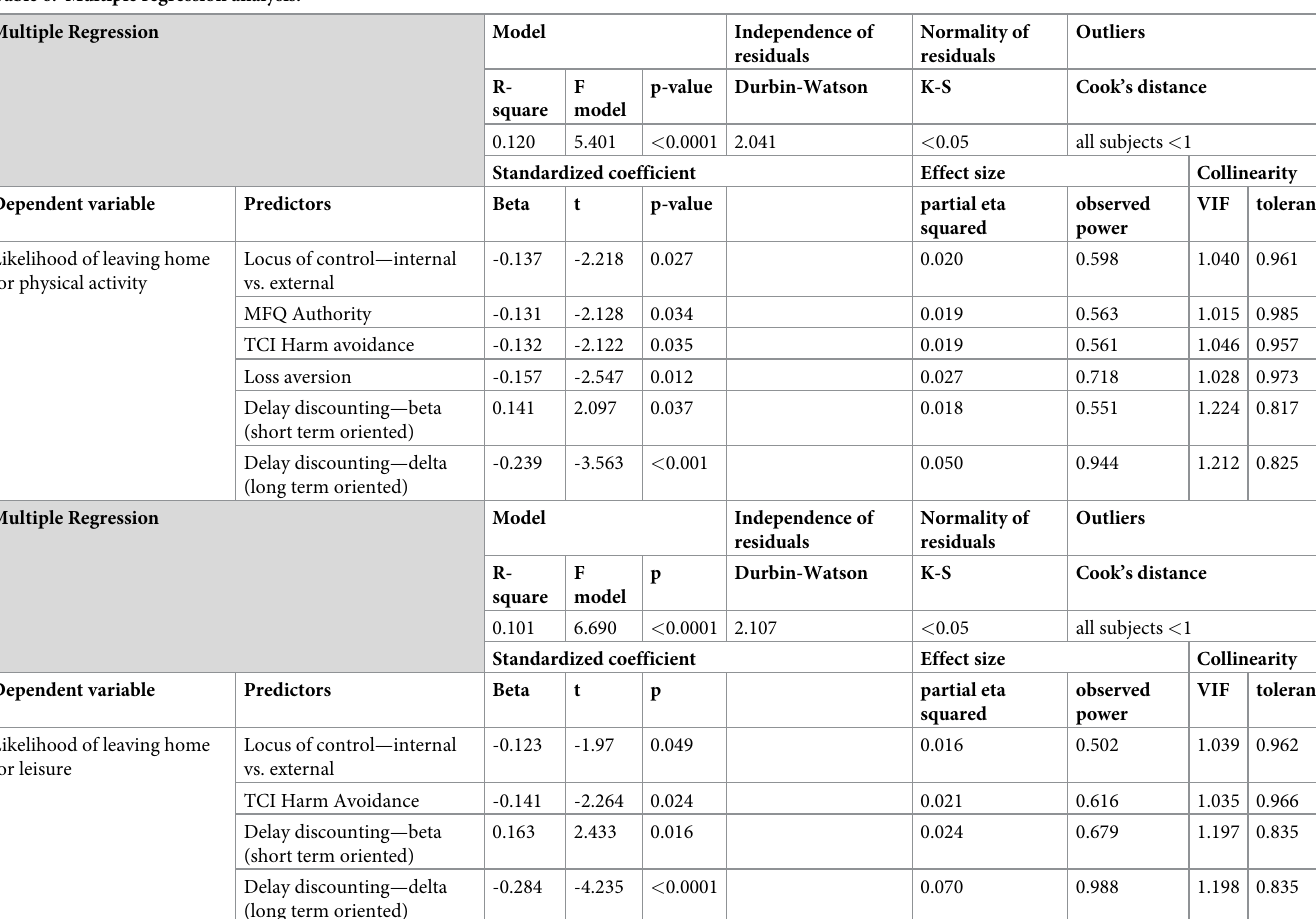
Table 6. Multiple regression analysis. Multiple Regression